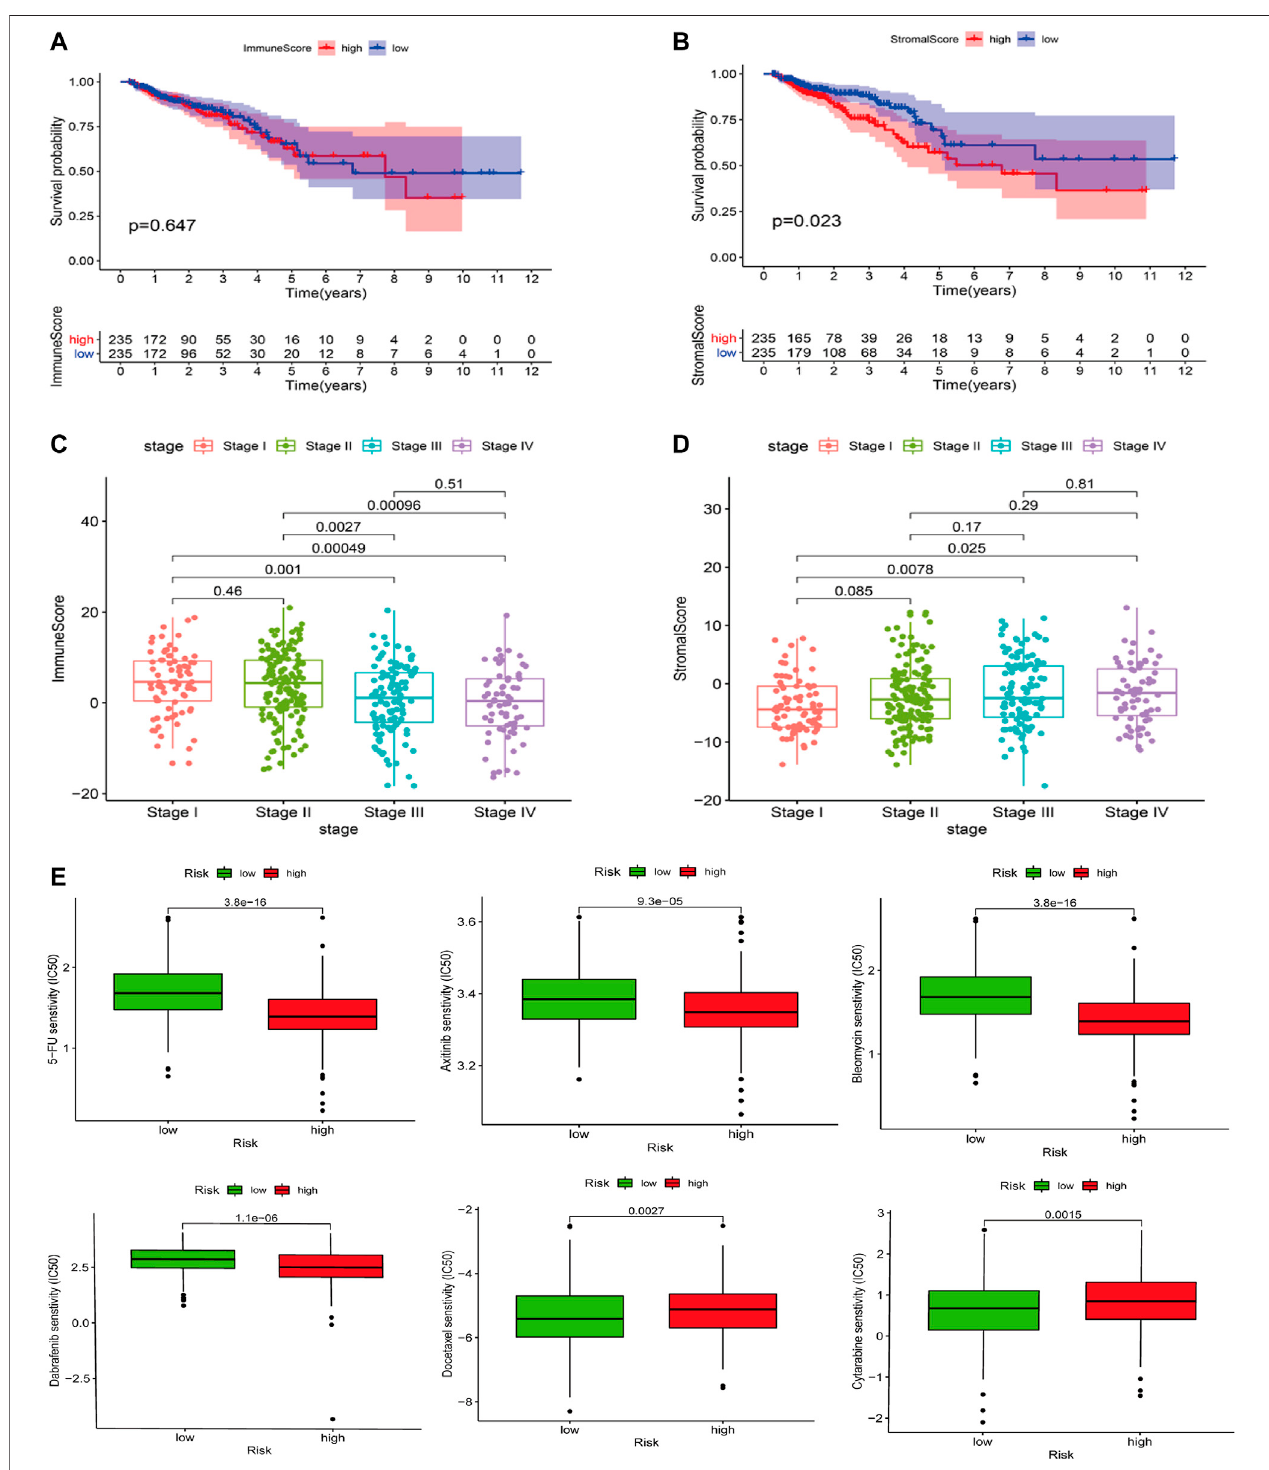
FIGURE9| ESTIMATEresults. (A) Associationwiththestromalscoreandtheriskscore.ThehighRSgroupshowedagreaterstromalscorecomparedwiththelow RS group. (B) Impact of the stromal score on OS in CRC cases based on KM analysis. (C,D) Correlation of the stromal score and the immune score with clinicopathological stage characteristics. (E) The IC50 value of 5-FU, axitinib, Bleomycin, Dabrafenib, Docetaxel, and Cytarabinein in different risk score groups.